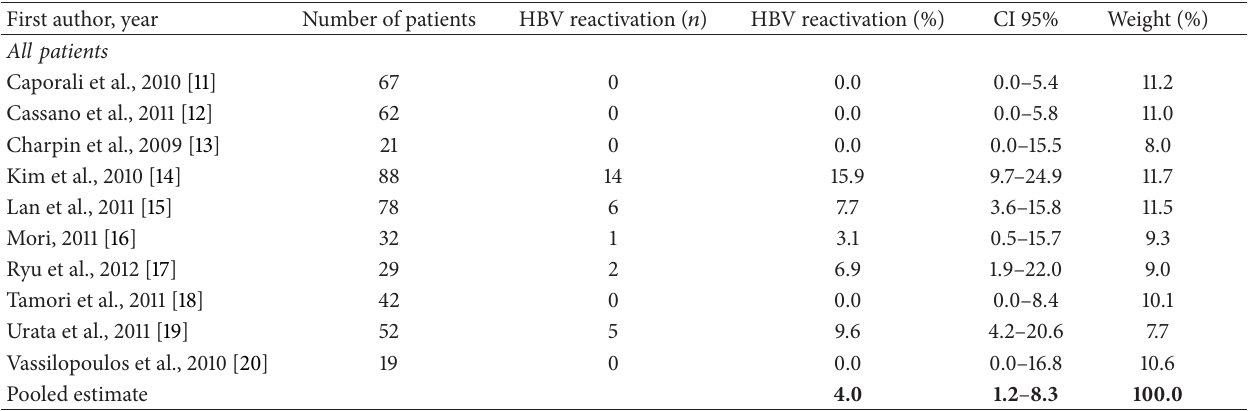
Table 6: Meta-analysis on HBV reactivation among patients with no antiviral